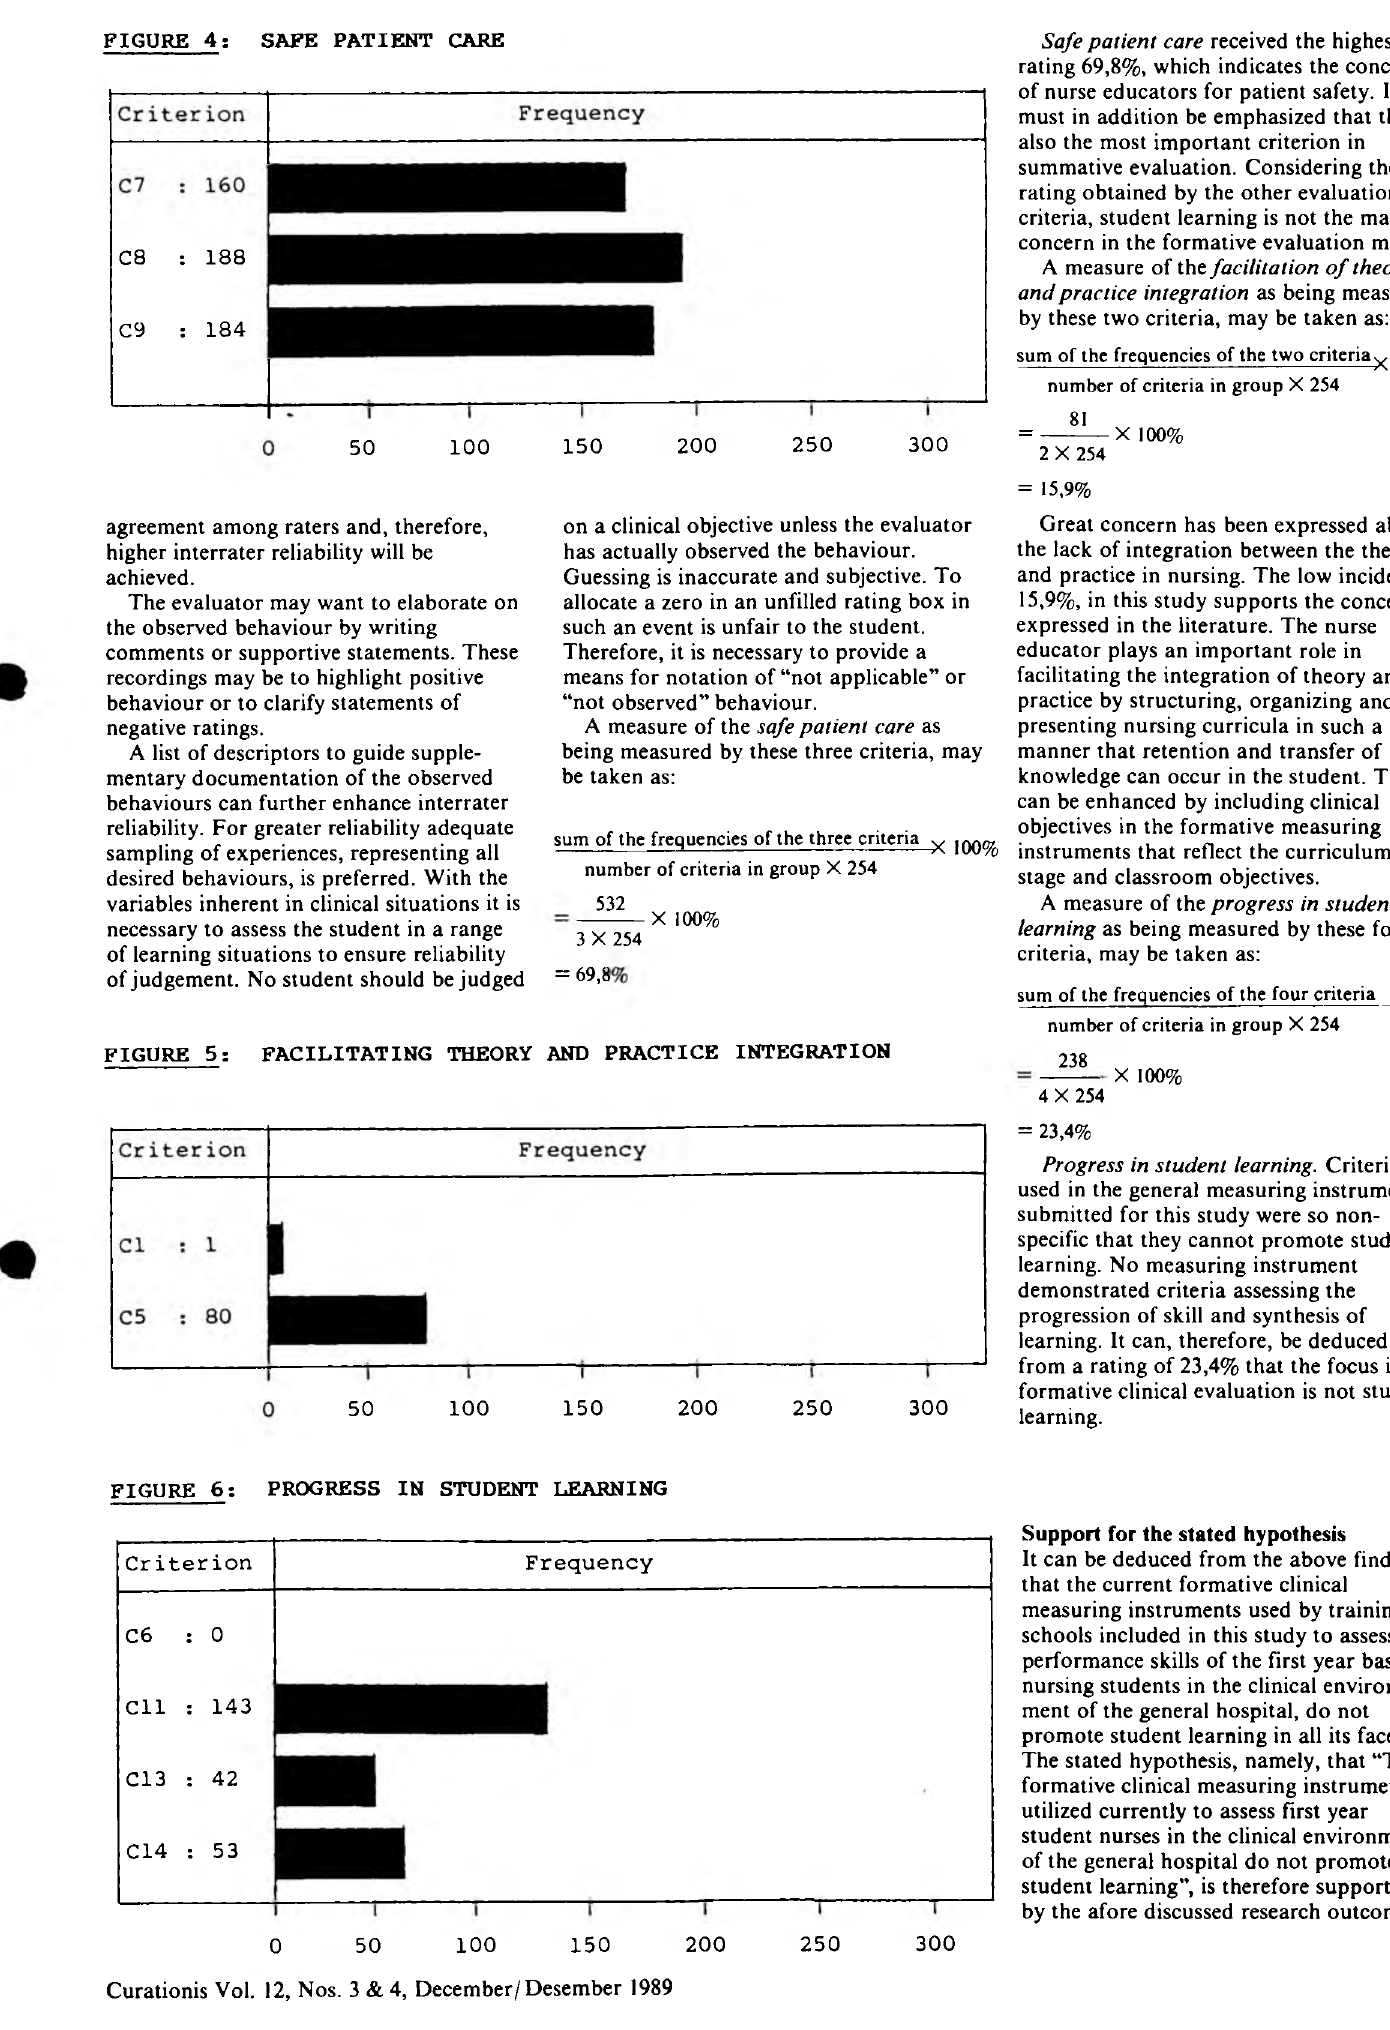
FACILITATING THEORY AND PRACTICE